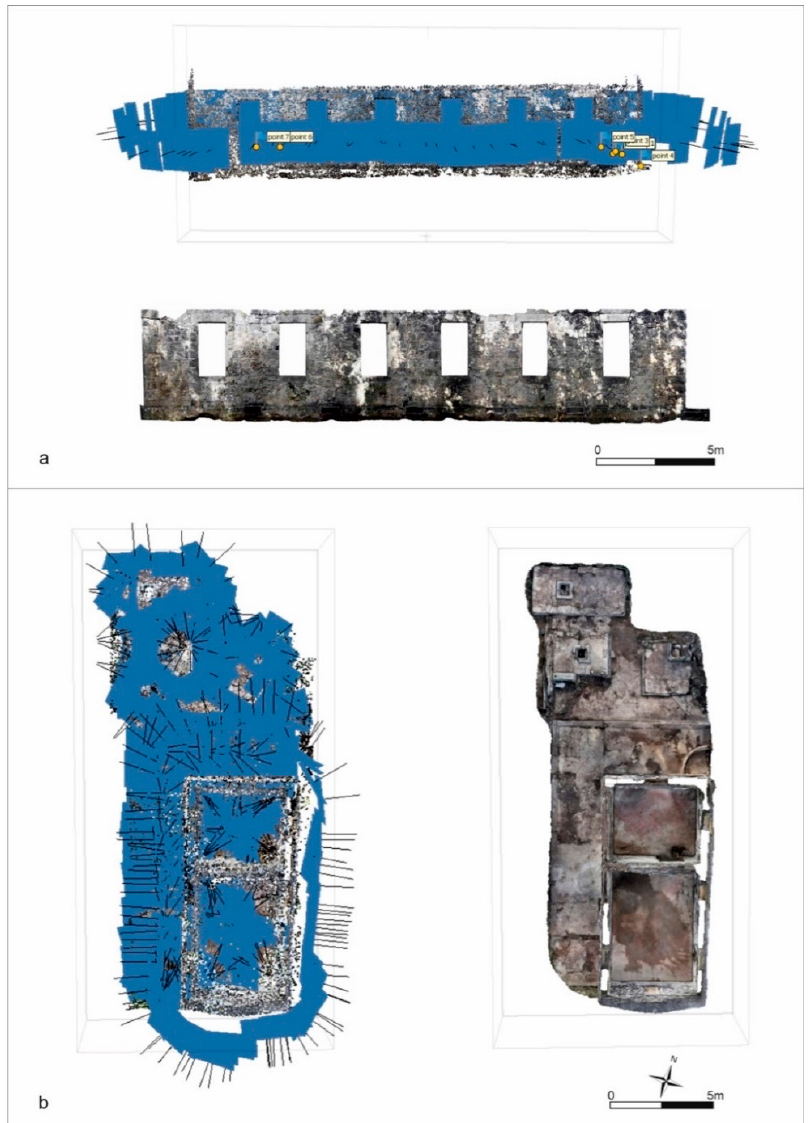
Figure 4. Examples of point clouds obtained using image-based modelling: ( a ) photogrammetric orthomosaic image of the hospital (Str. 127), south elevation; ( b ) photogrammetric orthomosaic